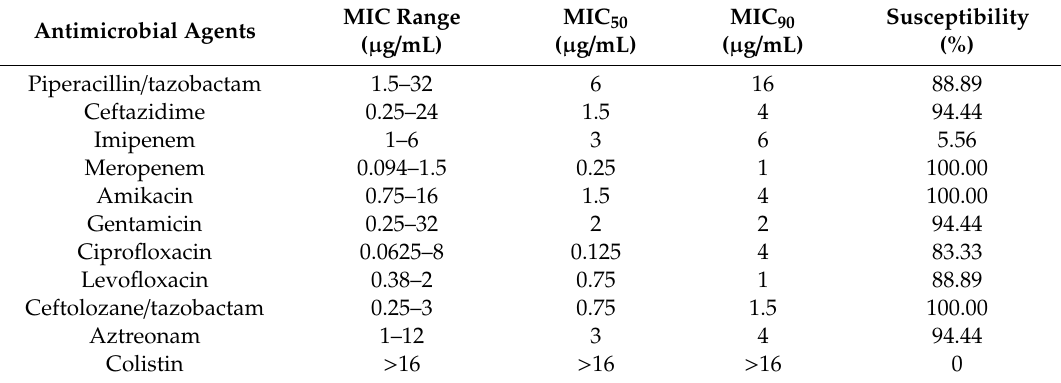
Table 1. Antimicrobial susceptibilities of colistin-resistant P. aeruginosa